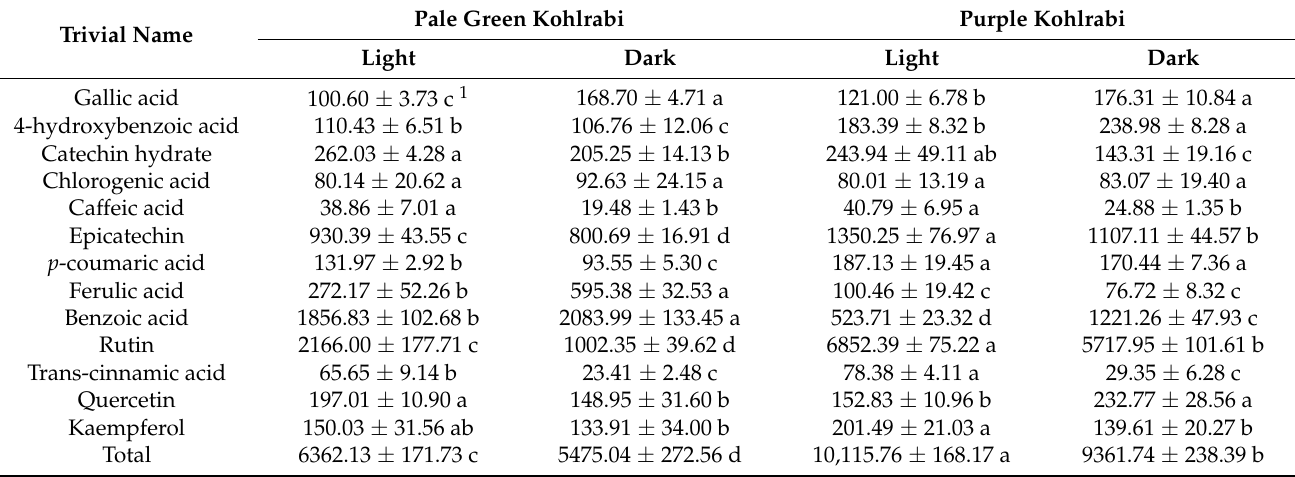
Table 1. Accumulation of phenolic compounds ( µ g/g DW) during the sprout development of pale green and purple kohlrabi under dark and light